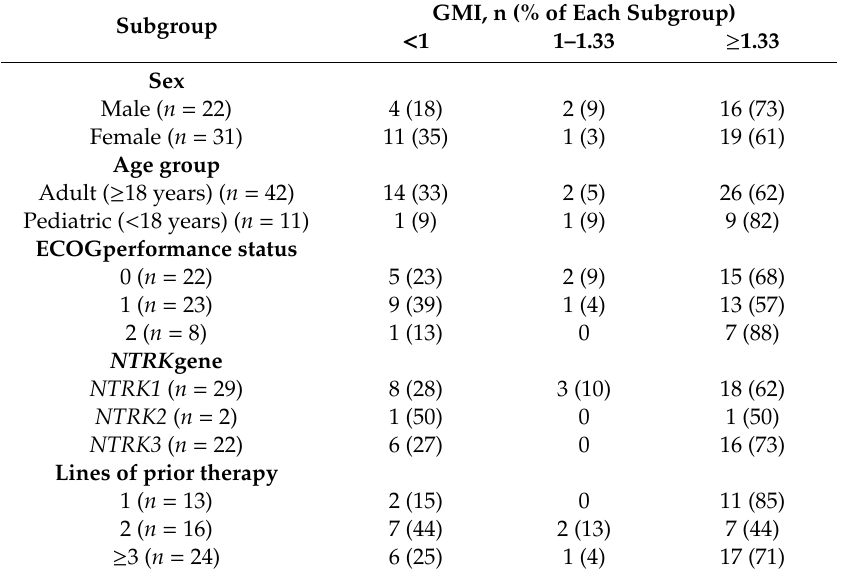
Table 2. Growth modulation index by patient subgroup for patients with metastatic disease ( n = 53).